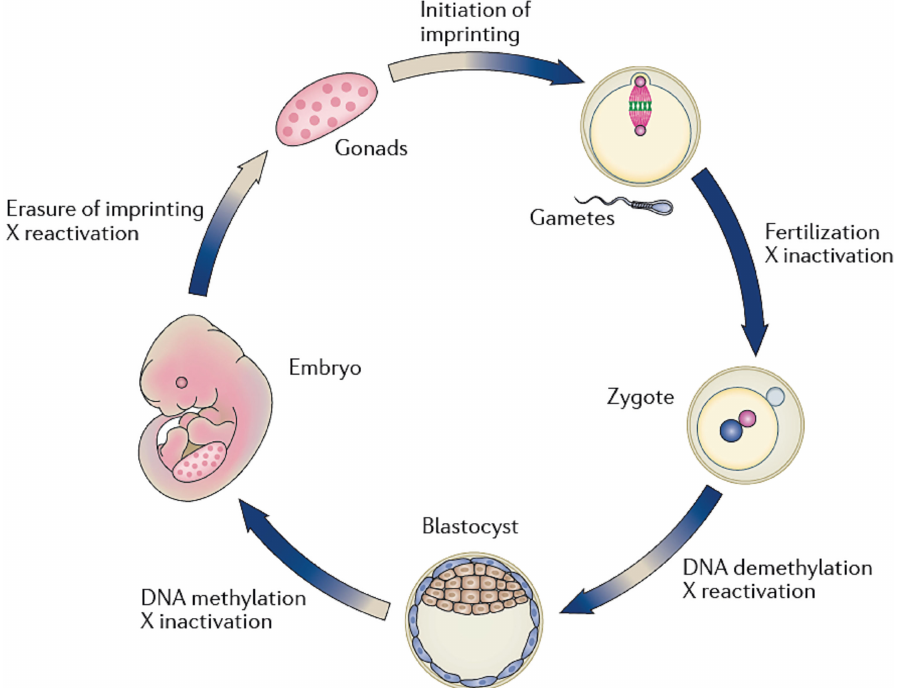
Figure 2. The epigenetic reprogramming cycle. The two major waves of epigenetic reprogramming occur during gametogenesis and after fertilization. During gametogenesis, most parental epigenetic marks are erased and re-established at the time of oogenesis and spermatogenesis. A second epige- netic reprogramming wave occurs soon after fertilization with a fast, active paternal demethylation and a slower, passive maternal demethylation. New methylation patterns are established at the blas- tocyst stage in the inner cell mass, while the trophectoderm stays relatively unmethylated. Adapted with permission from Ref